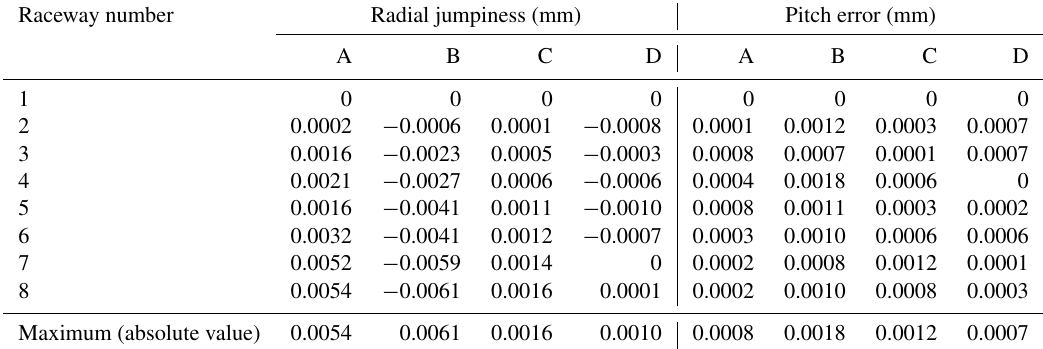
Table 4. Radial jumpiness and pitch